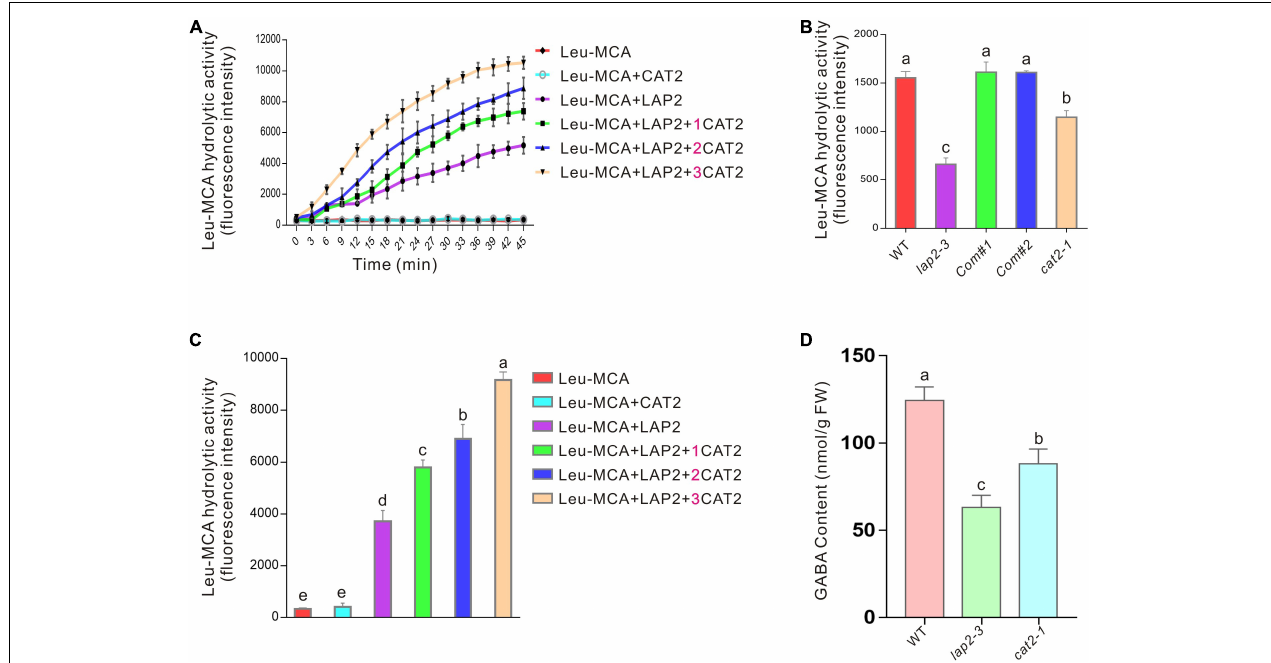
FIGURE 6 | CAT2 promotes LAP2 activity. (A) The kinetics experiment of LAP2 hydrolysis activity with Leu-MCA as the substrate in the presence or absence of CAT2 for 45 min; 1 µ g of purified LAP2 protein and different amounts of purified CAT2 protein (0, 1, 2, or 3 µ g) were added in the reaction mixture. (B) The fluorescence intensities of the above experiment (A) at 30 min were analyzed. (C) The leucine peptidase activity of 10-days-old wild-type, lap2-3 , LAP2 complementation lines and cat2-1 mutant seedlings with Leu-MCA as the substrate. (D) GABA content of 10-days-old wild-type, lap2-3 , LAP2 complementation lines and cat2-1 mutant seedlings. Data are means ( ± SD) of three biological replicates. Bars with different letters indicate significant differences at p < 0.05, revealed using one-way ANOVA with Tukey’s multiple comparison test.